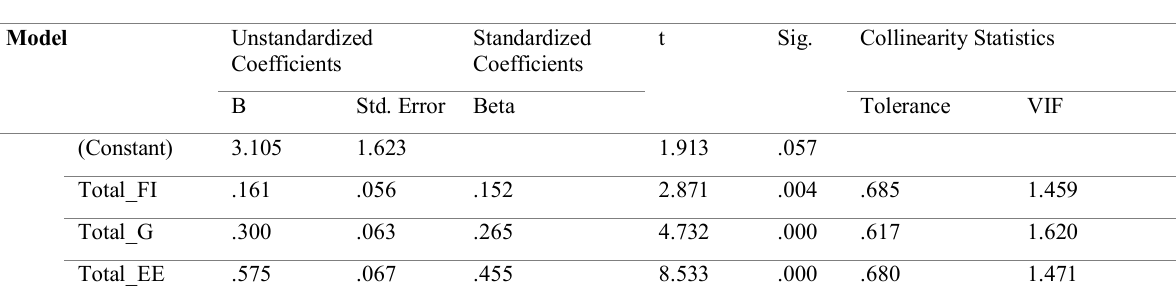
Table 1: Multiple regression analysis-